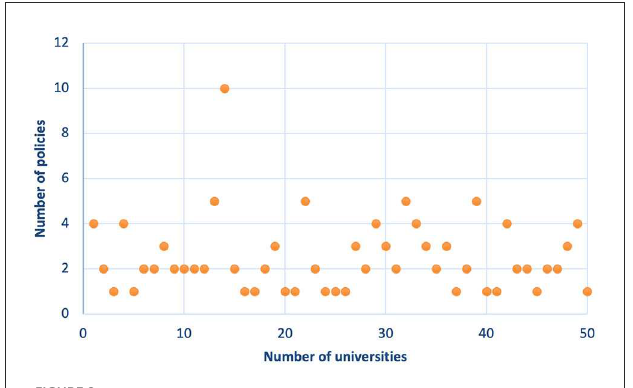
FIGURE3 Distribution of the time of promulgation of RI policies in universities. The number RI policies developed/and implemented throughout the years. The x-axis shows the year of development/implementation, and the y-axis shows the number of